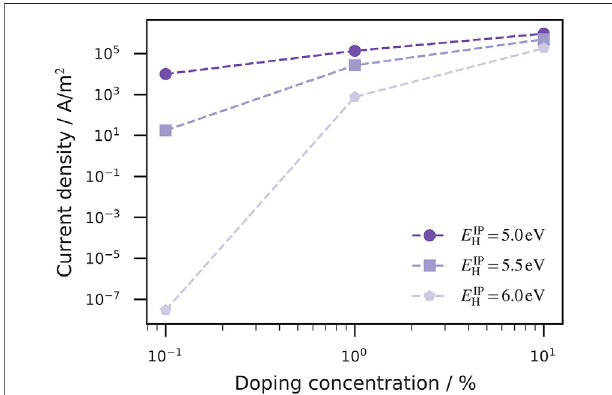
FIGURE 6 | Current density as a function of the doping concentration and host ionization potentials (IP). The relation between the IP of the host materials and the anode workfunction determine the initial hole injection barrier. At small doping concentrations (0.1%) the current density for the host material with E IP H (cid:1) 6.0 eV is very small compared to the current densities of the devices with other host materials ( E IP H (cid:1) 5.0 – 5.5 eV). A doping concentration of 1% increases the current density of the device with E IP H (cid:1) 6.0 eV by nine orders of magnitude. The current enhancing effect is much weaker for the devices with lower initial injection barriers. The